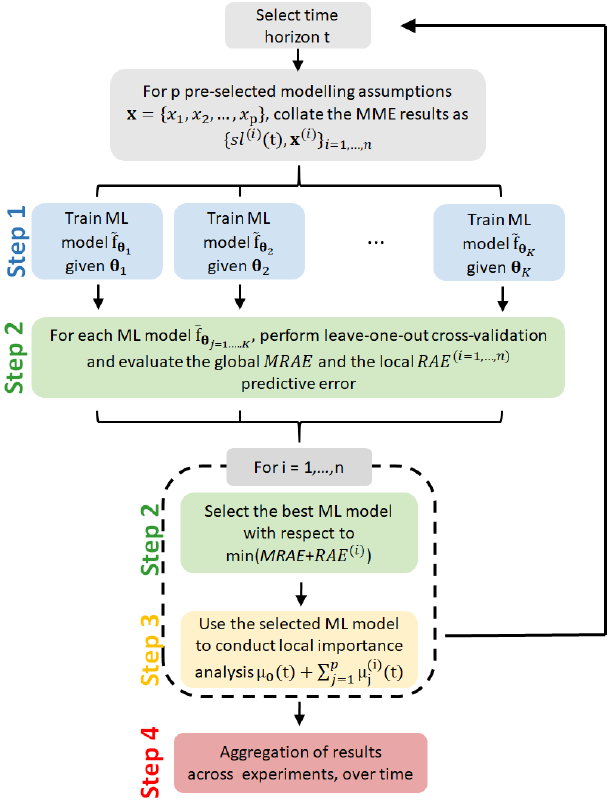
Figure 3. Schematic overview of the different steps of the proce-